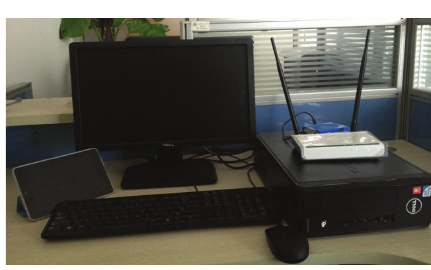
Figure 6: 3D-ODDL platform.